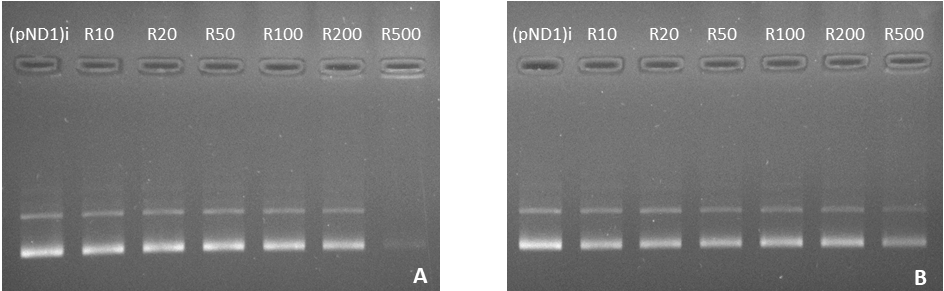
Figure 4. Agarose gel electrophoresis of the initial pND1 solution ((pND1)i) and supernatants resulting from the formulation of PEI–DQA (10 kDa)/pND1 systems (PEI–DQA N/P = 10, 20, 50, 100, 200, and 500) ( A ) and PEI–DQA (25 kDa)/pND1 systems (PEI–DQA N/P = 10, 20, 50, 100, 200, and 500) ( B ).